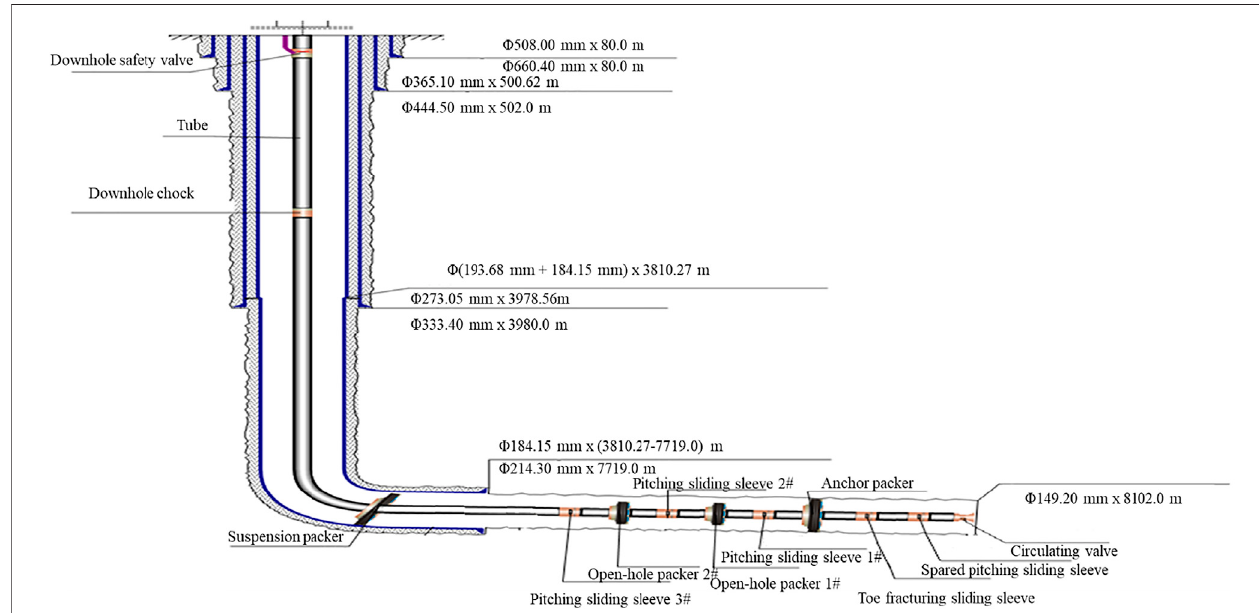
FIGURE 12 | Schematic diagram of the open-hole staged acid fracturing tool string for well M.